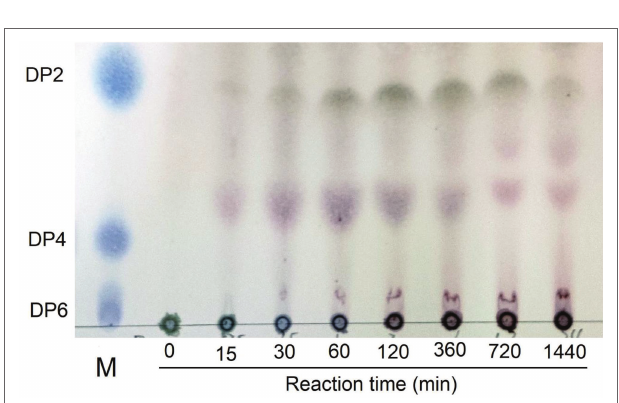
FIGURE 6 | Thin-layer chromatogram of degradation products by recombinant Car1383. See Materials and Methods for details of standard assay conditions. a. Lane M: standard samples of neocarraobiose (Dp2), neocarraotetraose (Dp4), and neocarraohexaose (Dp6), respectively; Lane 0: Control, κ -carrageenan without Car1383 incubated for 60 min; Lane 15–1,440: Car1383 incubated with purified Car1383 for different reaction times